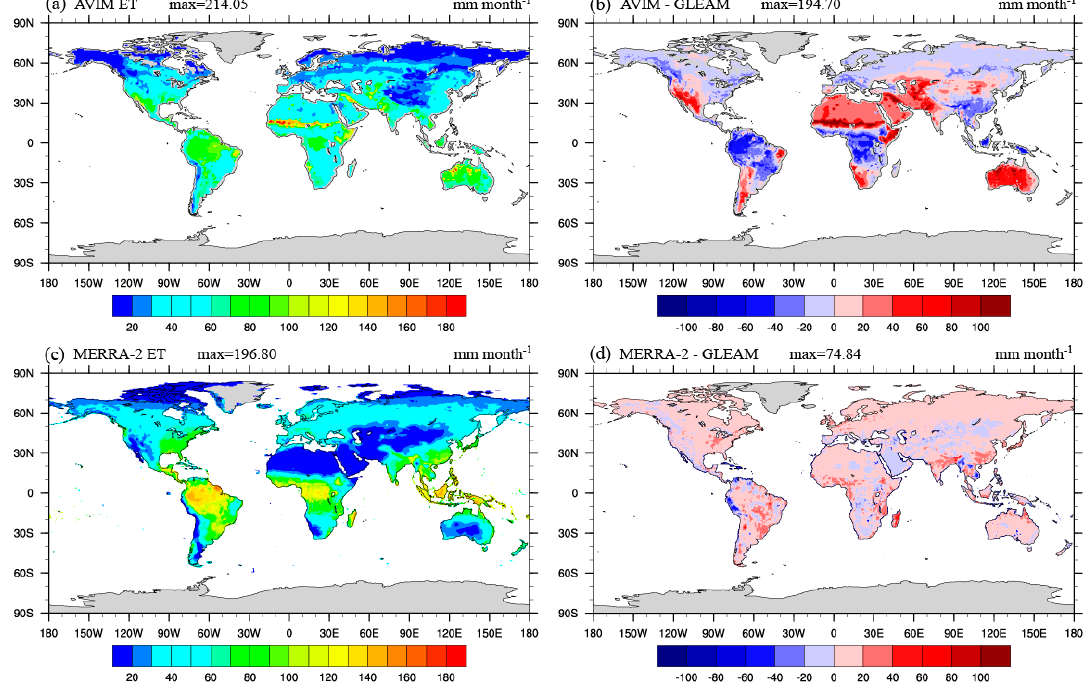
Figure 6. Monthly mean evapotranspiration (ET) of the AVIM ( a ) and MERRA-2 ( c ) datasets, and differences between the GLEAM dataset and the AVIM ( b ) and MERRA-2 ( d ) datasets.